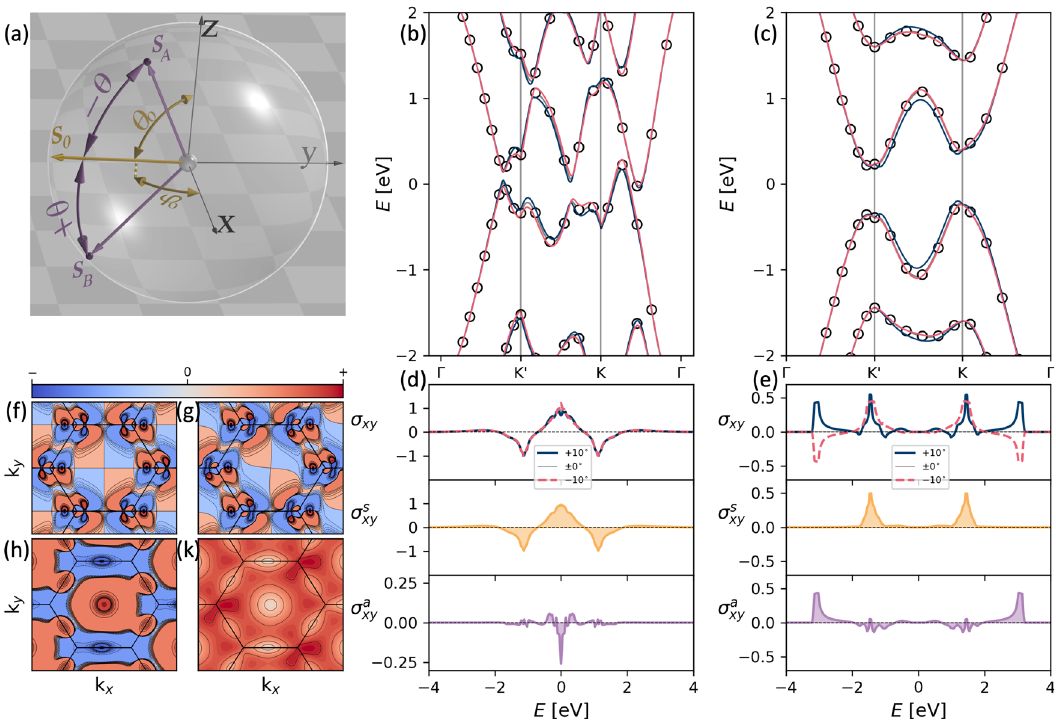
Fig. 2 The emergence of chiral and crystal Hall effect of ferro- and antiferromagnets on a honeycomb lattice. a The de fi nition of the angles used to characterize the canted spin structure of spins s A and s B . The initial direction of collinear magnetization ^ s 0 ¼ ð θ 0 ; φ angle φ 0 is kept constant during canting, ^ s 0 (cid:5) s A þ s B . The spins are canted in the plane of constant φ 0 by an angle θ for s A and − θ for s B with respect to ^ s 0 . The changes in the bandstructure of the ferromagnetic (FM) ( b ) and antiferromagnetic (AFM) ( c ) spins initially along ±10 ∘ . The thin gray line with circles marks the initial bandstucture while blue and red lines mark the bandstructure for θ = 10 ∘ and θ = − 10 ∘ , respectively. The corresponding anomalous Hall conductivity (AHC), σ xy , as a function of the Fermi energy is shown for the FM ( d ) and AFM ( e ) cases for positive (solid blue line) and negative (dashed red line) canting. The symmetric, σ s xy , and antisymmetric, σ a xy , parts of the AHC are shown with dark orange and dark blue lines. All values are in e 2 / h , where e is the elementary charge and h is Planck ’ s constant. f – k While for the high-symmetry direction of ^ s 0 ¼ ð 100 (cid:4) ; 0 (cid:4) Þ the symmetry properties of the Berry curvature of the fi rst two bands in the FM case, Ω a (10 ∘ , k ), lead to vanishing overall chiral Hall effect ( f ), the breaking of symmetry for ^ s 0 ¼ ð 100 (cid:4) ; 10 (cid:4) Þ results in a net effect ( g ). The complex structure of Ω a (10 ∘ , k ) of the fi rst band from ( c ) in k-space, ( h ), is clearly correlated with the separation between the fi rst and second bands in energy, shown in k